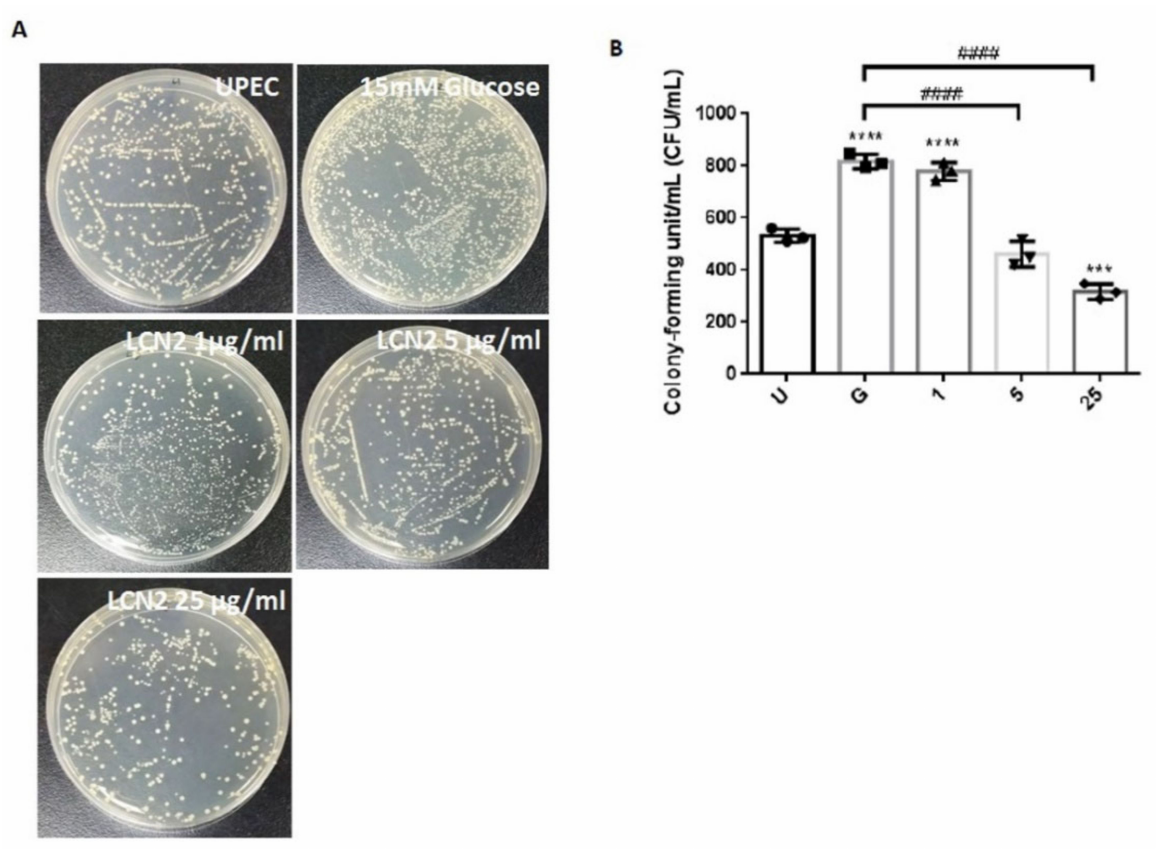
Figure 1. LCN2 suppression of UPEC infections in bladder cells in a high-glucose environment. SV-HUC-1 cells were first pretreated with 15 mM glucose, followed by treatments with different concentrations of LCN2 (1, 5, and 25 µ g/mL) for 24 h and infection with pGFP-UPEC (MOI of 1:100) for 4 h, as described in the text. The definitions of the letters on the X axis: U, UPEC infection alone; G, with 15 mM glucose pretreatment alone. UPEC infections in bladder cells were examined by plating cells on NB agar ( A ) and were determined using ImageJ software ( B ). Colony-forming units/mL (CFUs/mL) were acquired after plating out lysed solutions of infected cells. The picture shown is representative of a typical result. The data are expressed as the means ± SDs of three independent experiments. An analysis of variance was used to evaluate differences between various treatment groups and controls. Statistical differences between groups were determined using the Mann– Whitney U Student’s t -test. Statistical significance was set at p < 0.05. *** p < 0.001, **** p < 0.0001 compared to the positive control groups. #### p < 0.0001 for comparisons between two